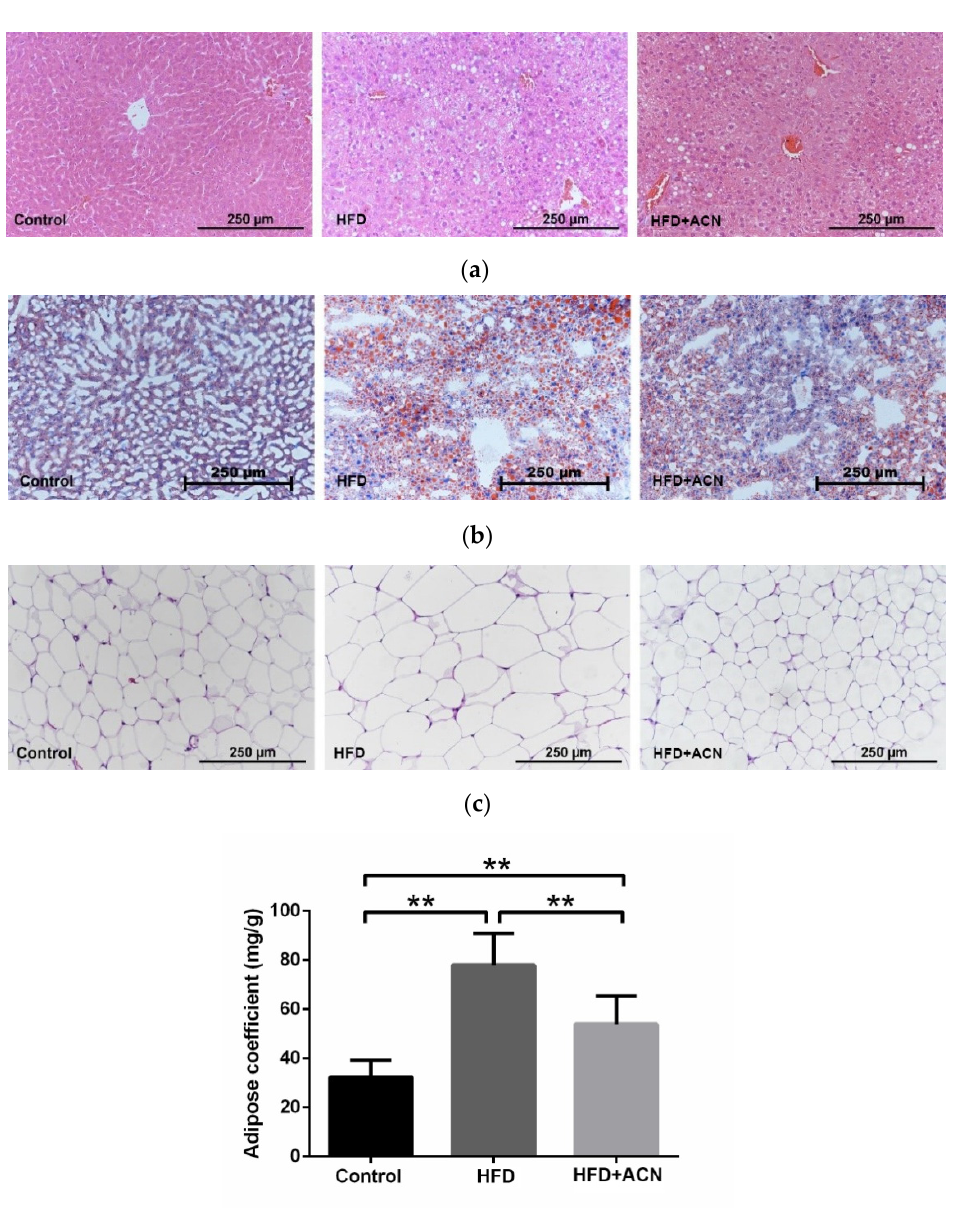
Figure 3. Morphology changes in the liver and adipose tissue. Photo images of H&E and Oil Red O staining of liver sections were photographed at × 200 magnification. Data are expressed as the mean ± SD (n = 8 for each group), ** denotes p < 0.01. ( a ) H&E staining of liver tissue. ( b ) Oil Red O